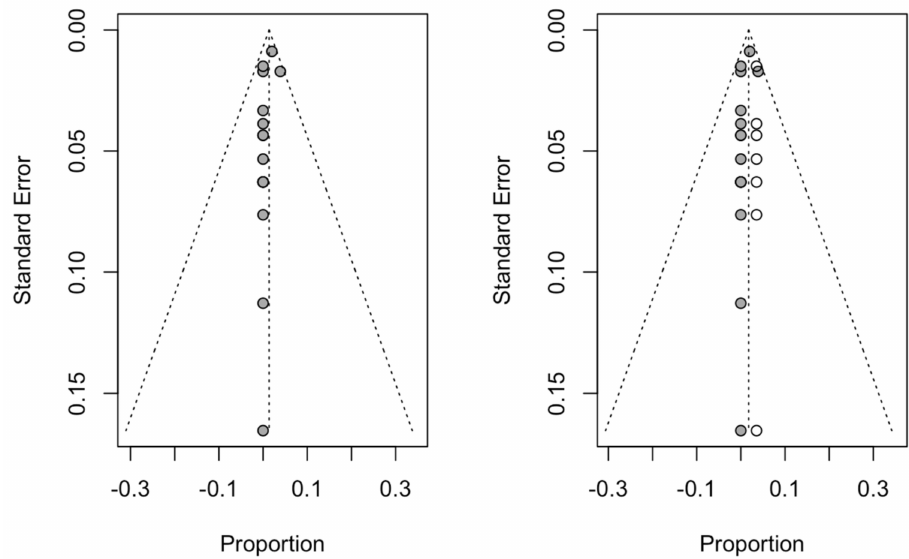
Figure 4. Initial funnel plot and plot after trim and fill adjustment of the dental implant failure of the socket-shield technique for dental immediate implant placement in the esthetic zone.